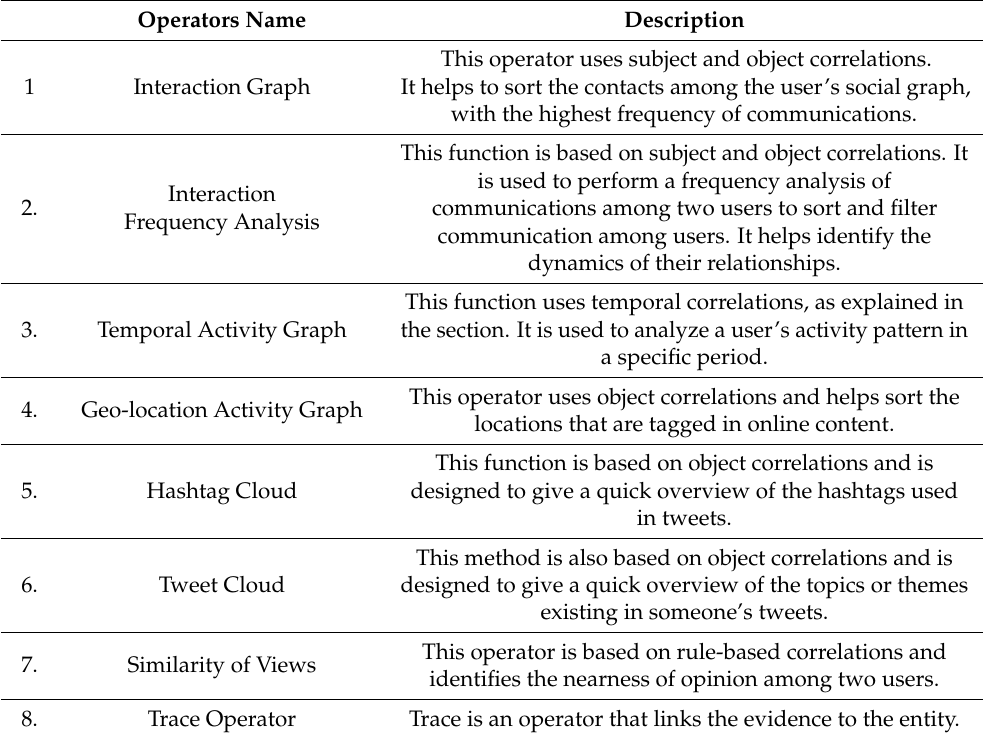
Table 4. List of Analysis